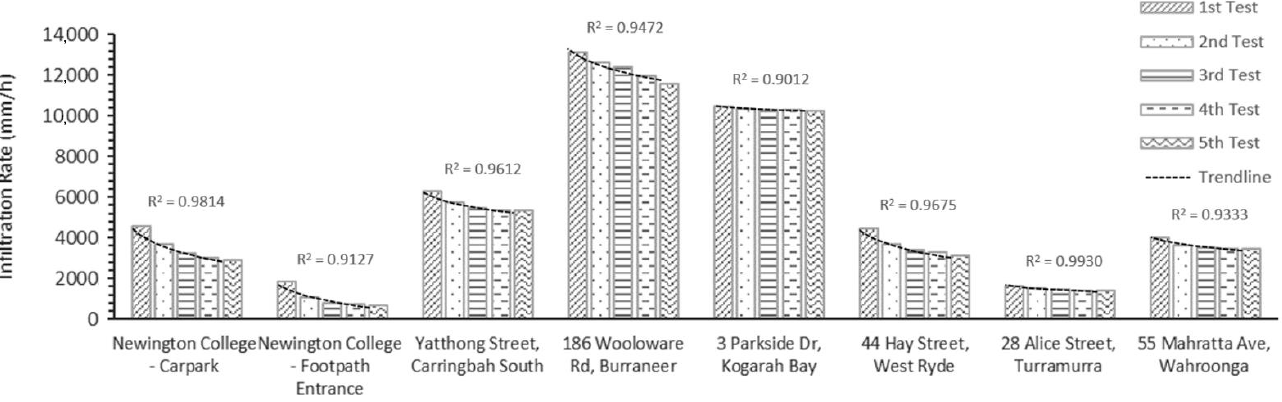
Figure 8. Infiltration rate verses the number of SRIT tests carried out.